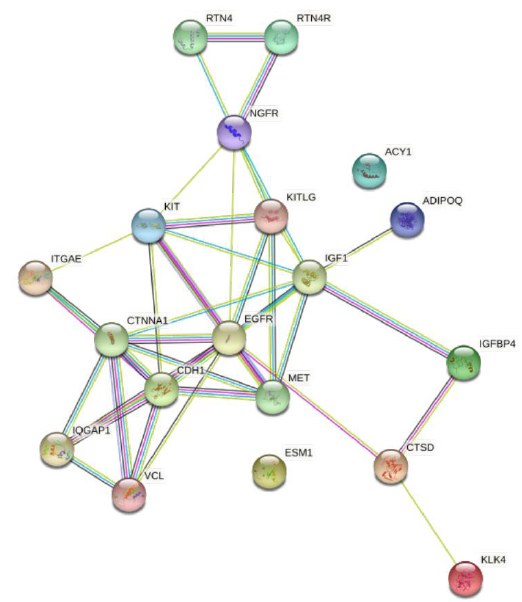
Figure 3. Correlation analyses of proteins. For age, there was a positive correlation with Kallikrein- 4 (KLK4) ( A ) and a negative correlation with Insulin-like growth factor-binding protein-4 (IGFBP4) ( B ) in T2D (blue squares). No correlations were observed with age in controls (black circle). For HOMA-IR, there was a positive correlation with Mast/stem cell growth factor receptor-Kit (KIT) ( C ) in T2D.